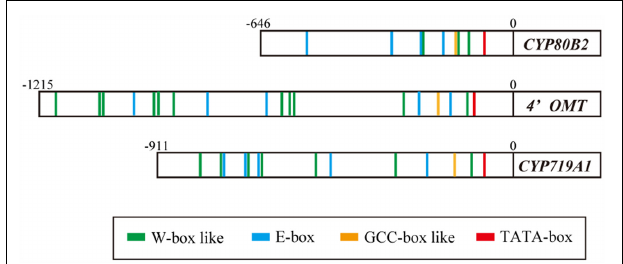
FIGURE 2 | Putative cis -acting elements in the promoter region of CYP80B2 , 4 (cid:48) OMT, and CYP719A1 genes. Putative cis -acting elements were predicted by PLACE searches. Red boxes indicate putative TATA-box. Green, blue and yellow boxes indicate predicted W-box, E-box, and GCC-box-like elements,